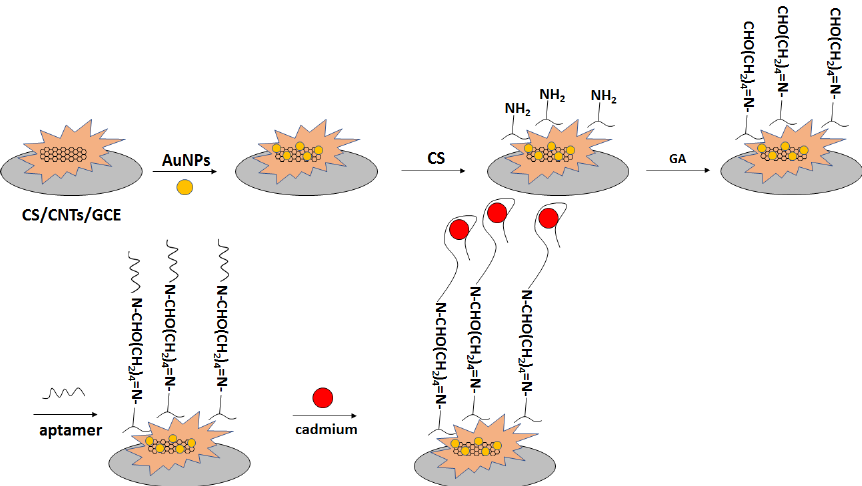
Figure 24. The sensing principle scheme of the electrochemical aptasensor toward cadmium ions with the application of a glassy carbon electrode modified with carbon nanotubes in chitosan solu- tion and impedance spectroscopy in the presence of a ferri/ferrocyanide redox indicator as an ana- lytical technique.